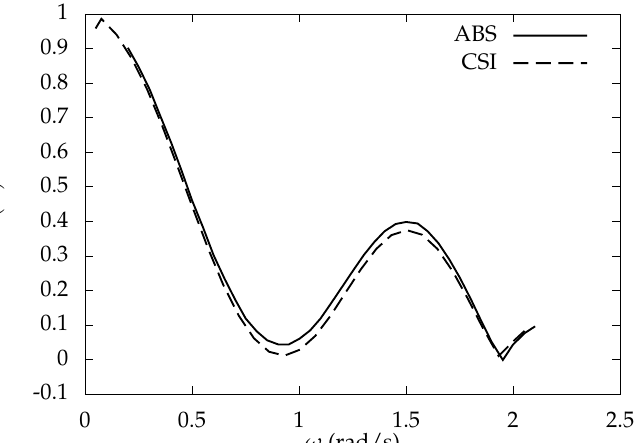
Figure 23. Effective wave slope function for KCS container ship computed using the simplified “formal” method. Table 27. Level 2 assessment of the dead ship failure mode for KCS container